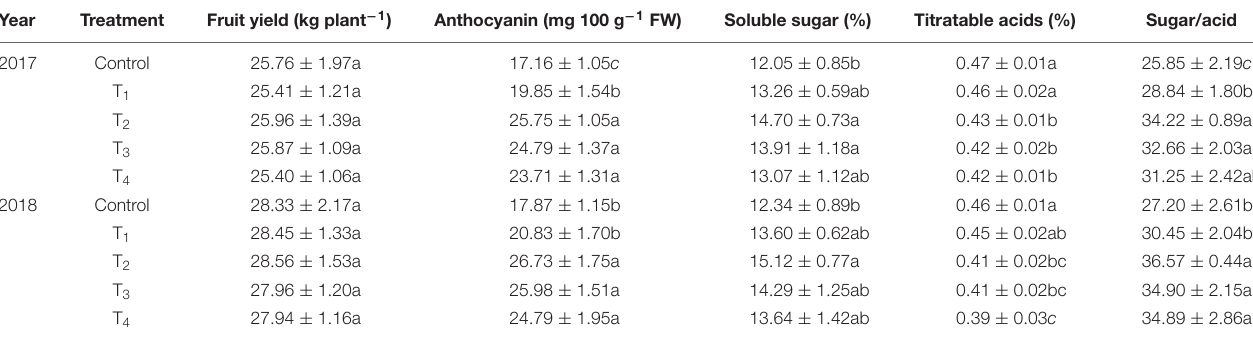
TABLE 4 | Effects of DMPP on fruit yield and quality at the fruit maturity stage. Year Treatment Fruit yield (kg plant − 1 ) Soluble sugar (%) Titratable acids